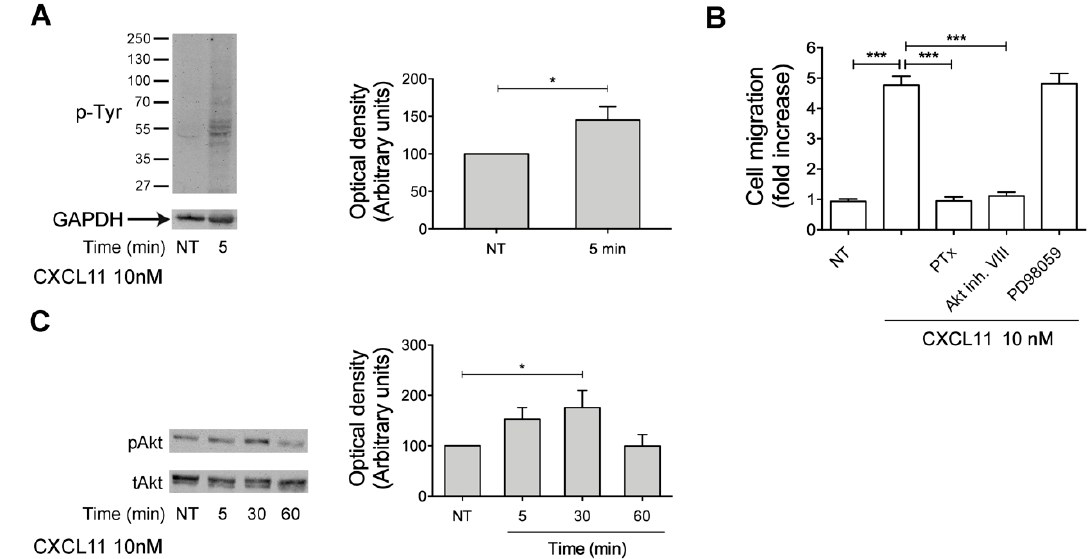
Figure 6. CXCL11–induced chemotactic activity, as PDT one, is mediated by Akt kinase. ( A ) Monocytes were treated or not for 5 min with 10nM of CXCL11. Western blot analysis of cells lysates shows that CXCL11 is able to induce an increase of Tyr phosphorylated proteins, as shown by densitometry analysis and plotting of the pTyr/GAPDH. In the left panel blots from one representative experiment of three with similar results are shown. In the right panels, values reported for protein Tyr phosphorylation are the mean ± SD of three independent experiments. Statistical analysis was performed by Student’s t -test, * p < 0.05. NT = not treated. ( B ) Transwell migration assay of monocytes in response to the indicated treatments. Monocytes pretreated with PTx (500 ng/mL) or Akt inhibitor VIII (1 μ M) or PD98059 (10 μ M) were stimulated for 90 min at 37 °C with PBS (NT) or CXCL11 (10 nM). Bars represent the means ± SD of 3 independent experiments performed in triplicate. Statistical analysis was performed by one-way ANOVA and the Bonferroni’s post-test was used to compare data. *** p < 0.001. ( C ) Monocytes were stimulated with 10 nM of CXCL11 at 37 °C for the indicated times. Not treated cells (NT) were used as control (lane 1). Western blot analysis of monocyte lysates shows that CXCL11 activates Akt, as shown by the respective phosphorylation state, verified by densitometric analysis and plotting of the phospho-Akt/total Akt (pAkt/tAkt). In the left panel blots from one representative experiment of three with similar results are shown. In the right panel, values reported for Akt phosphorylation are the mean ± SD of three independent experiments. Statistical analysis was performed by one-way ANOVA and the Bonferroni’s post-test was used to compare data, * p < 0.05.